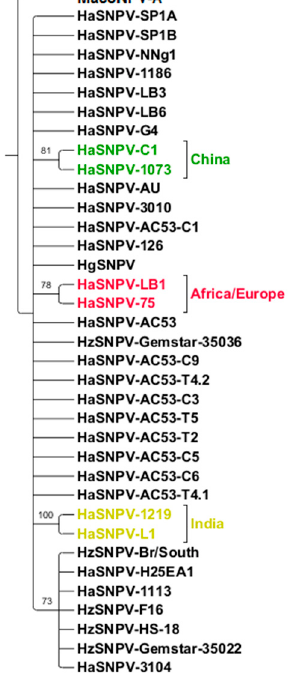
Figure 7. ORF61 (ORF62 homolog), rooted to MacoNPV-A, showing only six strains clustering based on geography.